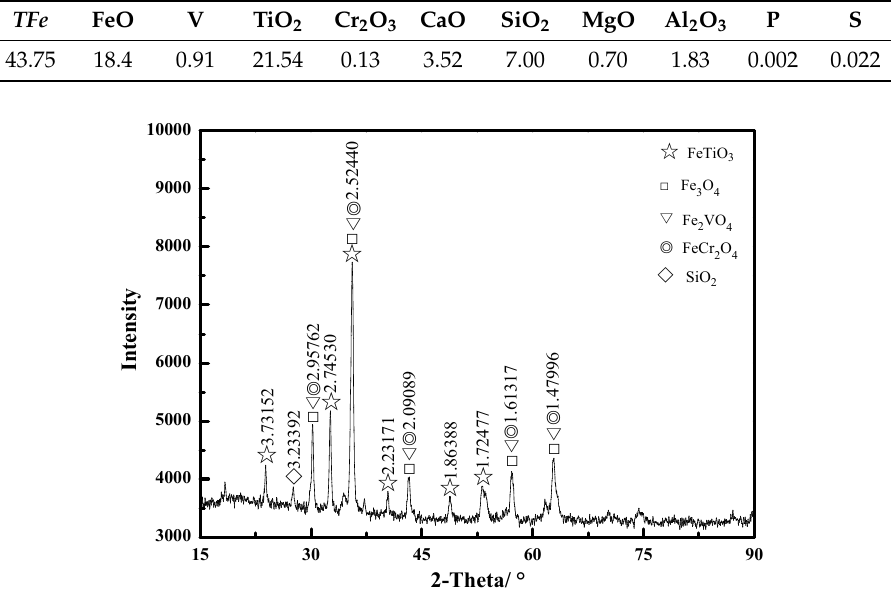
Figure 1. XRD pattern of LGVTM.